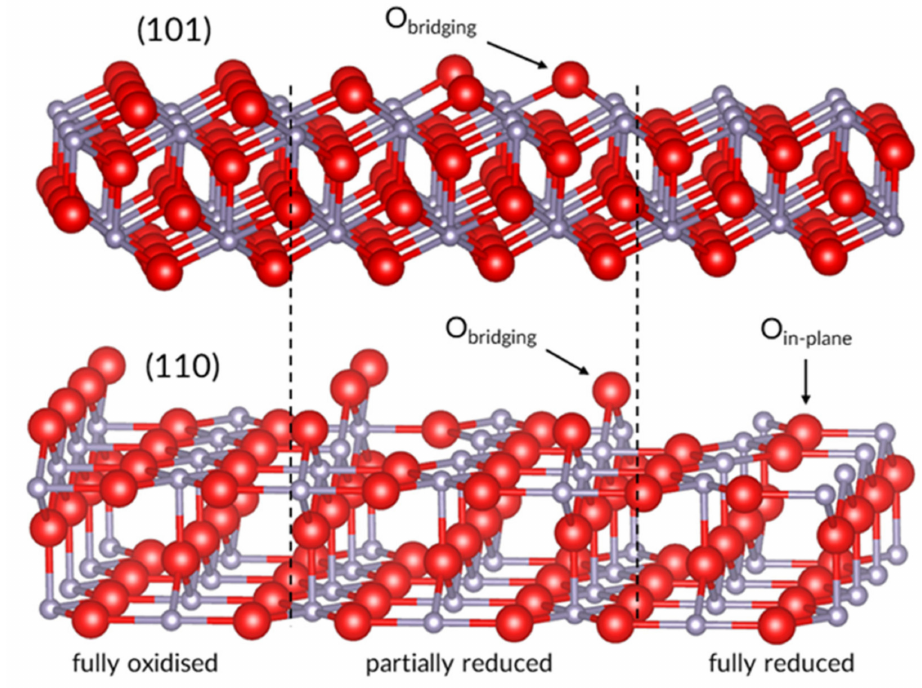
Figure 1. Progressing reduction of the ( 110 , 101 ) surfaces of SnO 2 . Image prepared in VESTA